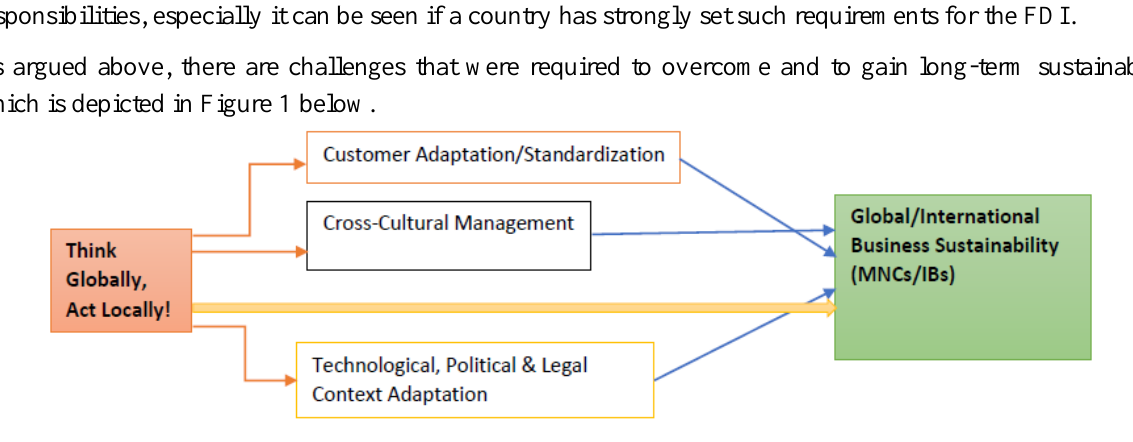
Figure 1. Sustainability Model before the pandemic. Source: Authors’